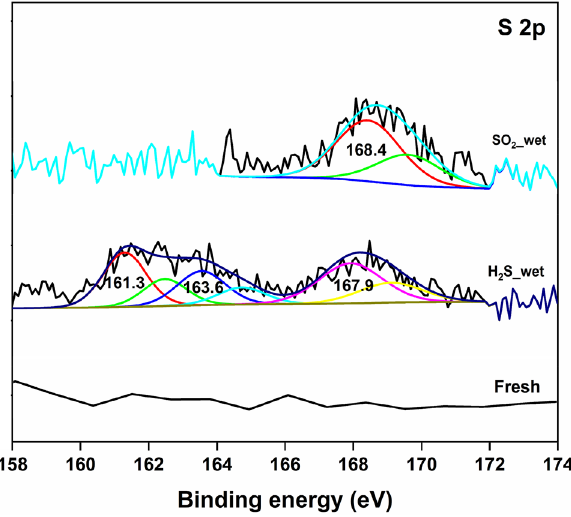
Figure 8. High-resolution XPS S 2p spectra of MFZO before and after H 2 S and SO 2